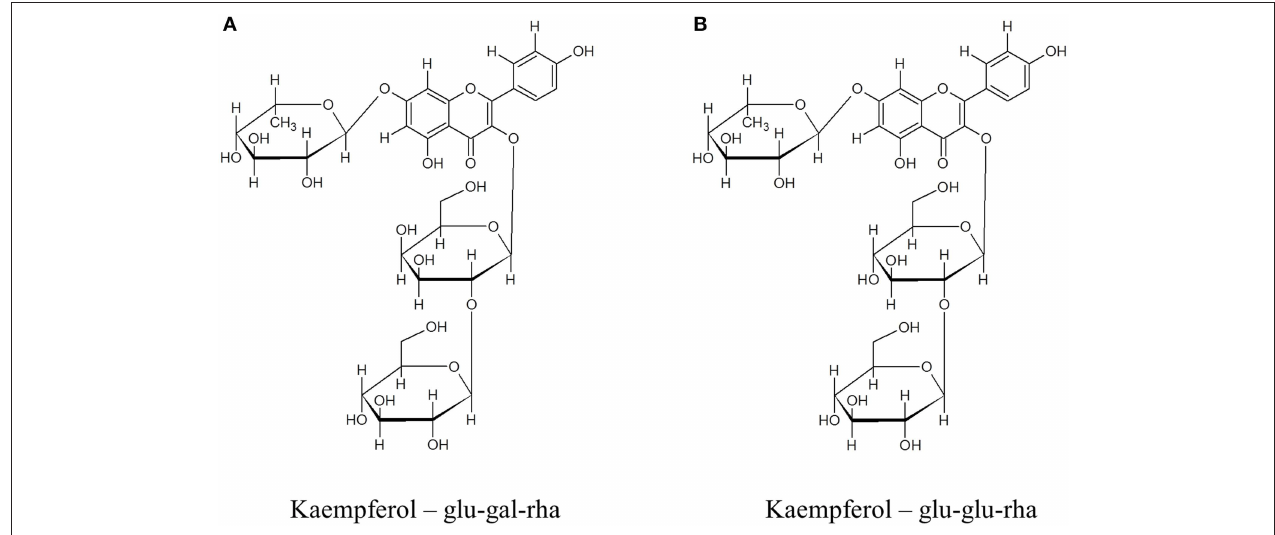
FIGURE 5 | Chemical structures of (A) kaempferol 3-O-glucosyl (1-2)-galactoside-7-O-rhamnoside and (B) kaempferol 3-O-glucosyl (1-2)-glucoside-7-O-rhamnoside. The compounds were purified from crude extracts of WT L. japonicus leaves from plants grown under control conditions by glass column chromatography followed by preparative HPLC. NMR determination of the chemical structure of the compounds was carried out as described in materials and